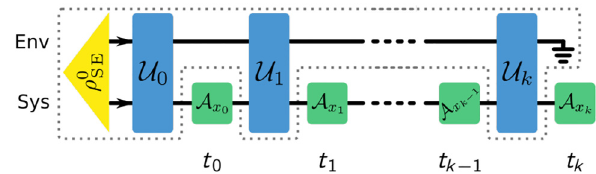
FIG. 16. General quantum stochastic process. The system of times T k = { t 0 , t 1 , . . . , t k } with corresponding CP maps A x A { A . . . , A } . In between measurements, the system and x 0 , x 1 , x k the environment together undergo closed, i.e., unitary